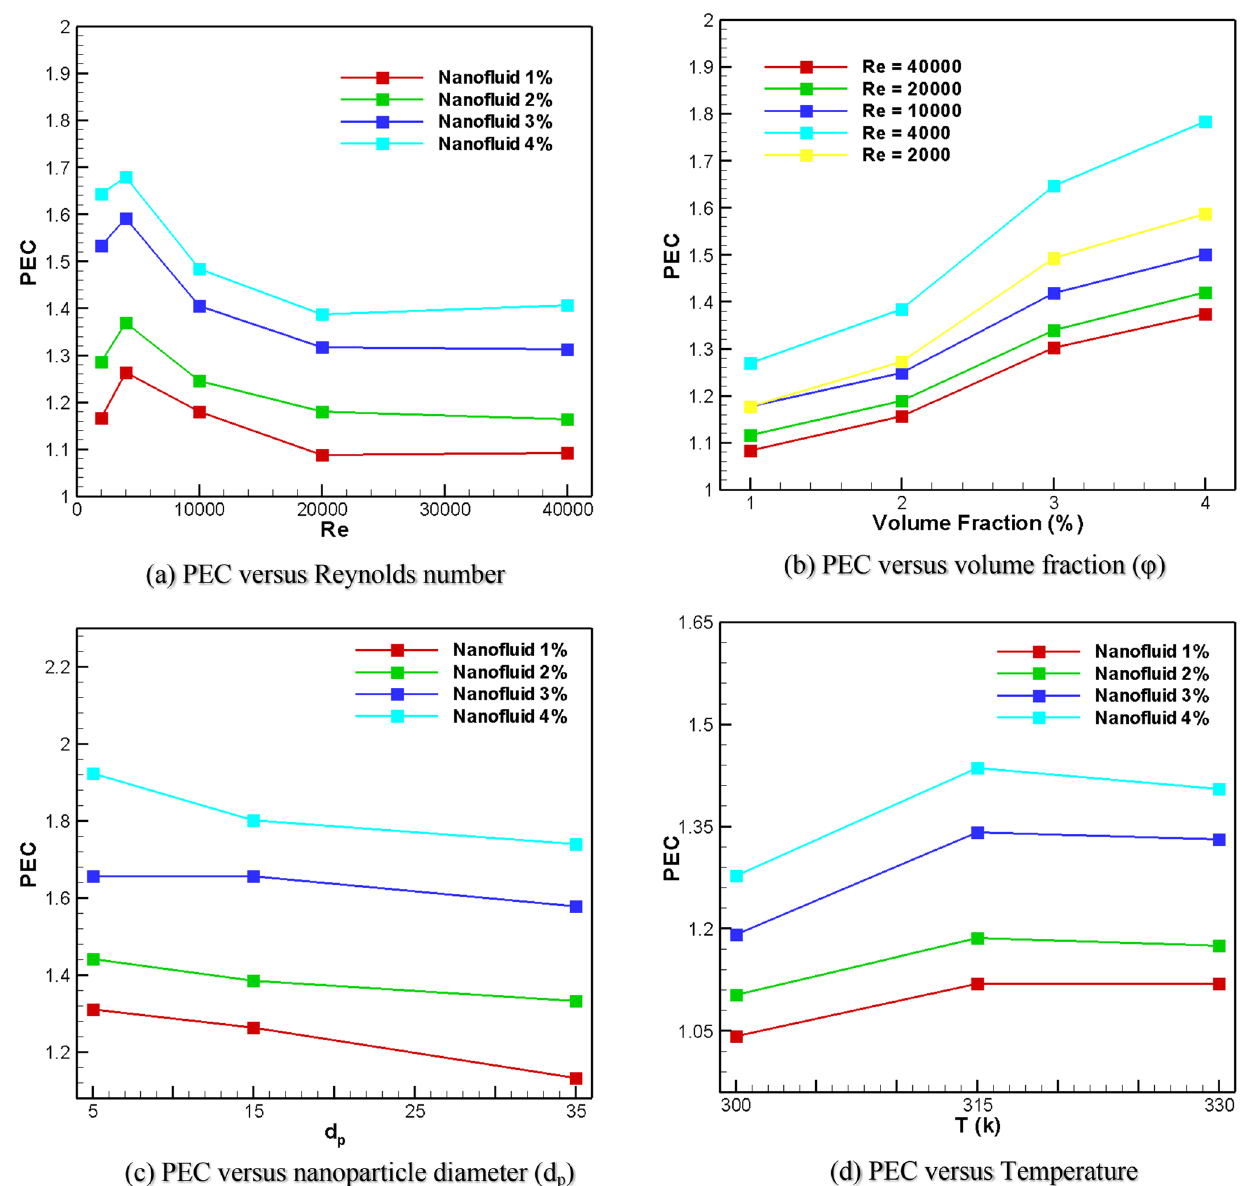
Reynolds. c d versus PEC for comparison between the different p amounts of φ. d T (k) versus PEC for comparison between the differ- ent amounts of